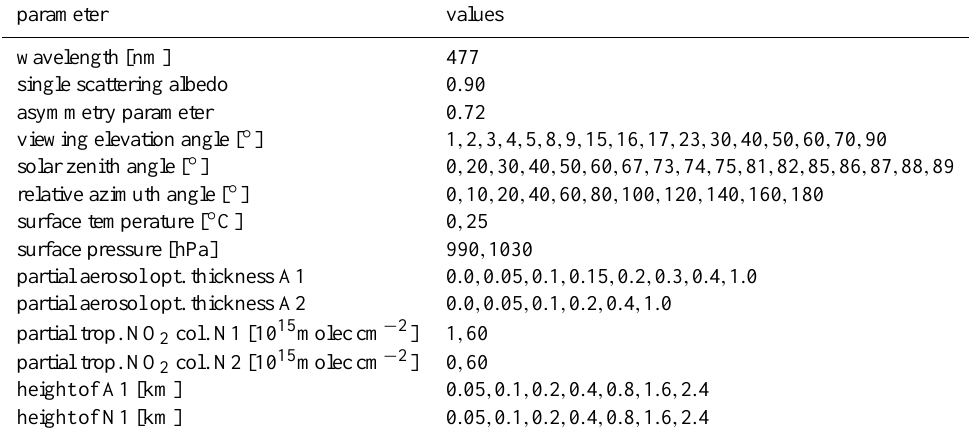
Table 1. Parameter values for which the look-up table was calculated. For each of these values, the look-up table contains simulated measurements of differential slant NO 2 columns, differential slant O 4 columns, and relative intensities. Multidimensional linear interpolation is used in the retrieval algorithm, in order to obtain simulated measurements in between the values for which the look-up table was calculated.